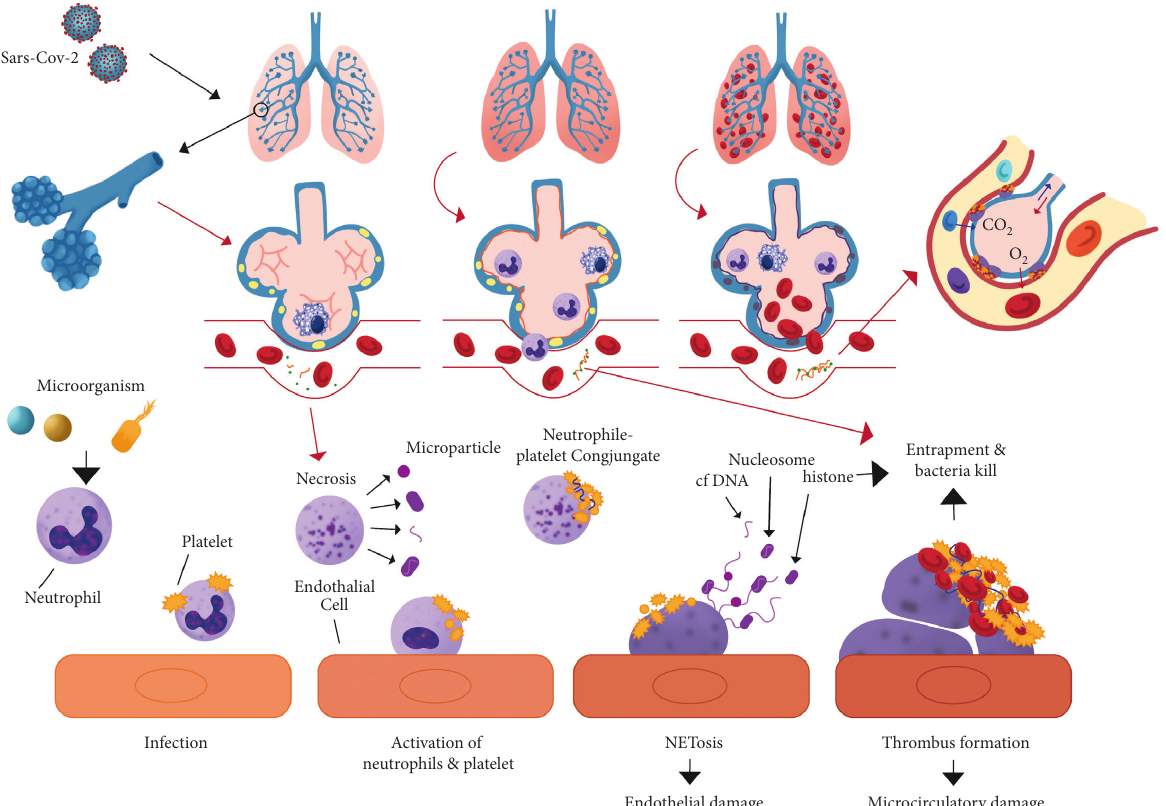
Figure 3: mechanism that explained SARS-CoV-2 infections NETosis and relations to hypoxic cell damage. The mechanism was adapted from Zhou et al. and Khafarijiy et al. [65, 66].